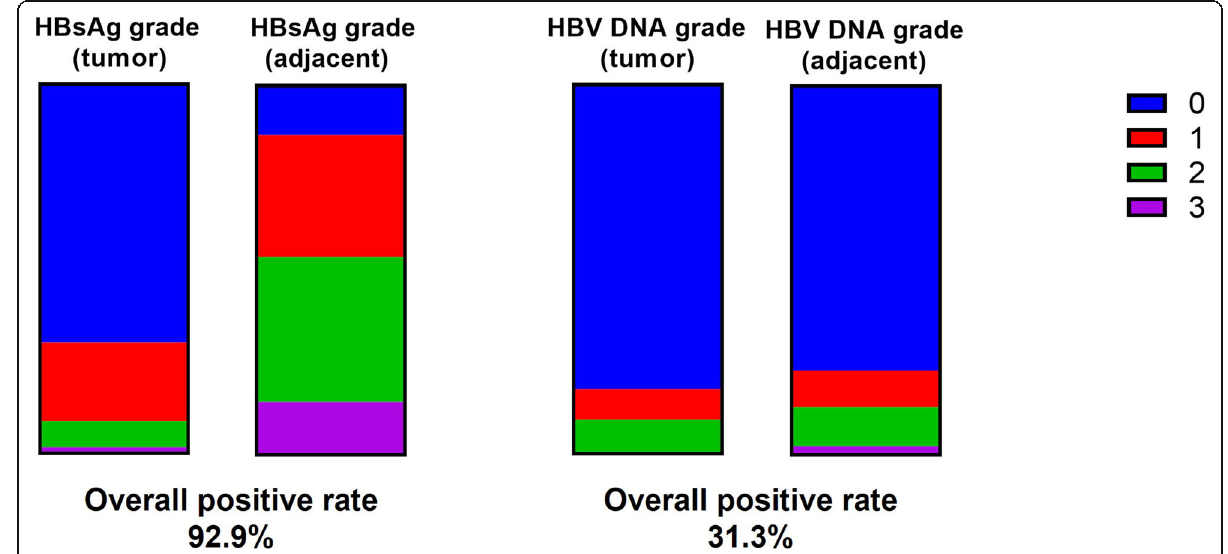
Fig. 1 Frequency of HBsAg IHC and HBV DNA ISH grades in liver tumor and adjacent tissues